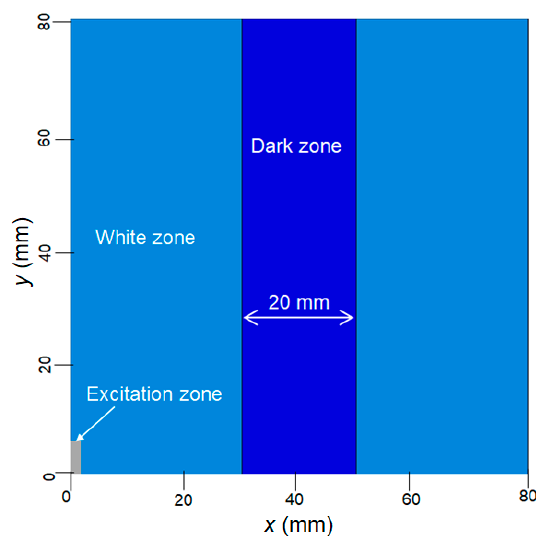
Figure 3. Sample of the mica paper with two zones with different elastic properties.